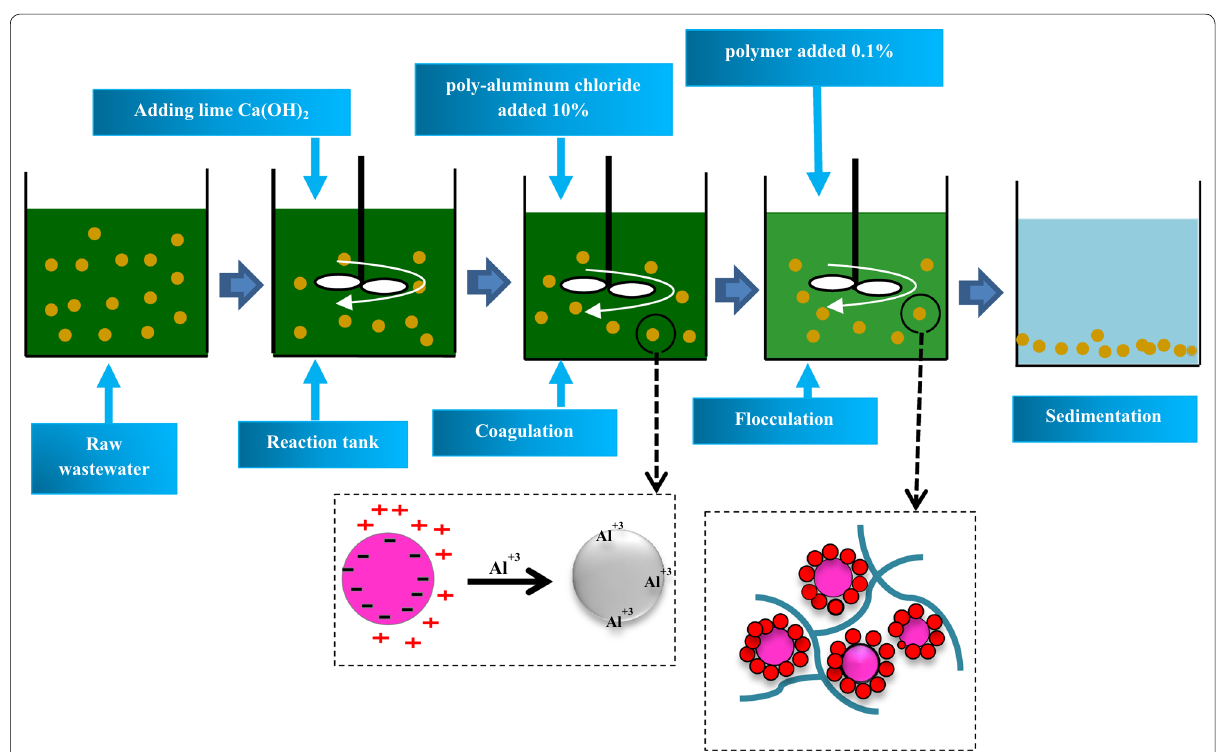
Fig. 1 Schematic the coagulation and flocculation process